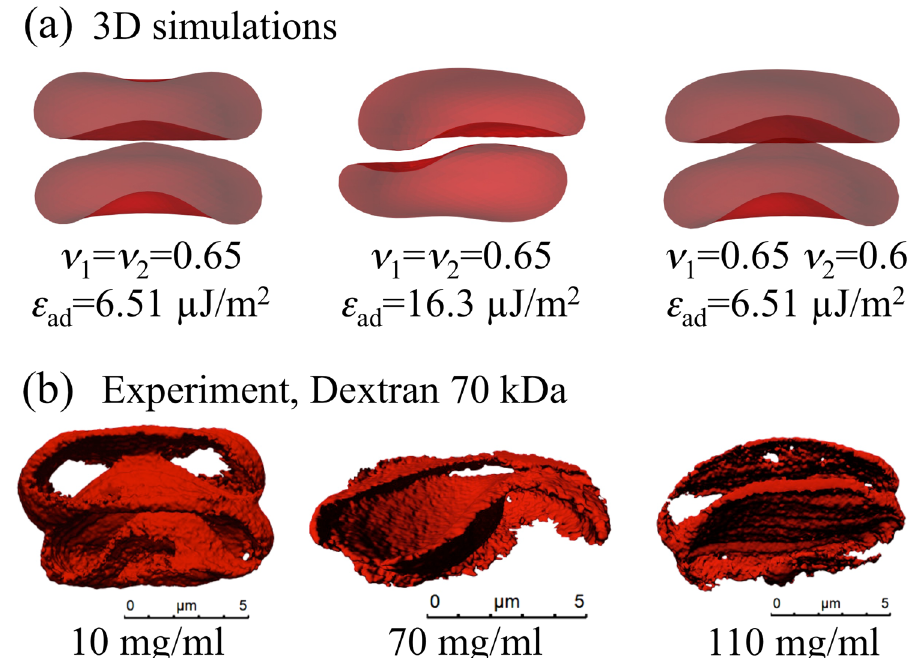
Figure 1. ( a ) Theoretical results (3D simulations) for RBC interaction and resulting contact zones for different reduced volumes ν and adhesion energies ε ad . ( b ) 3D-confocal imaging of RBC-doublets. The experimental results qualitatively reproduce the theoretical